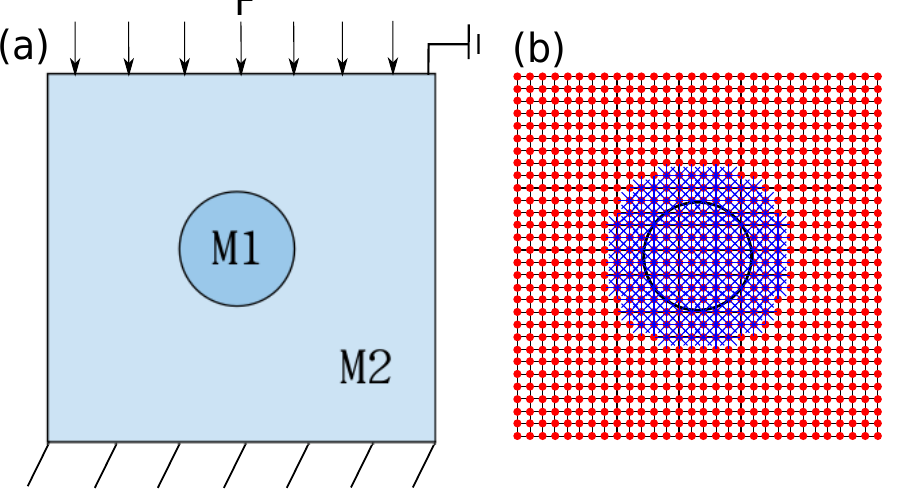
Figure 8. Schematic illustration of: ( a ) the square domain with center inclusion and its boundary condition; ( b ) MLS discretization with the red solid point representing the nodes and the blue asterisk representing the enriched